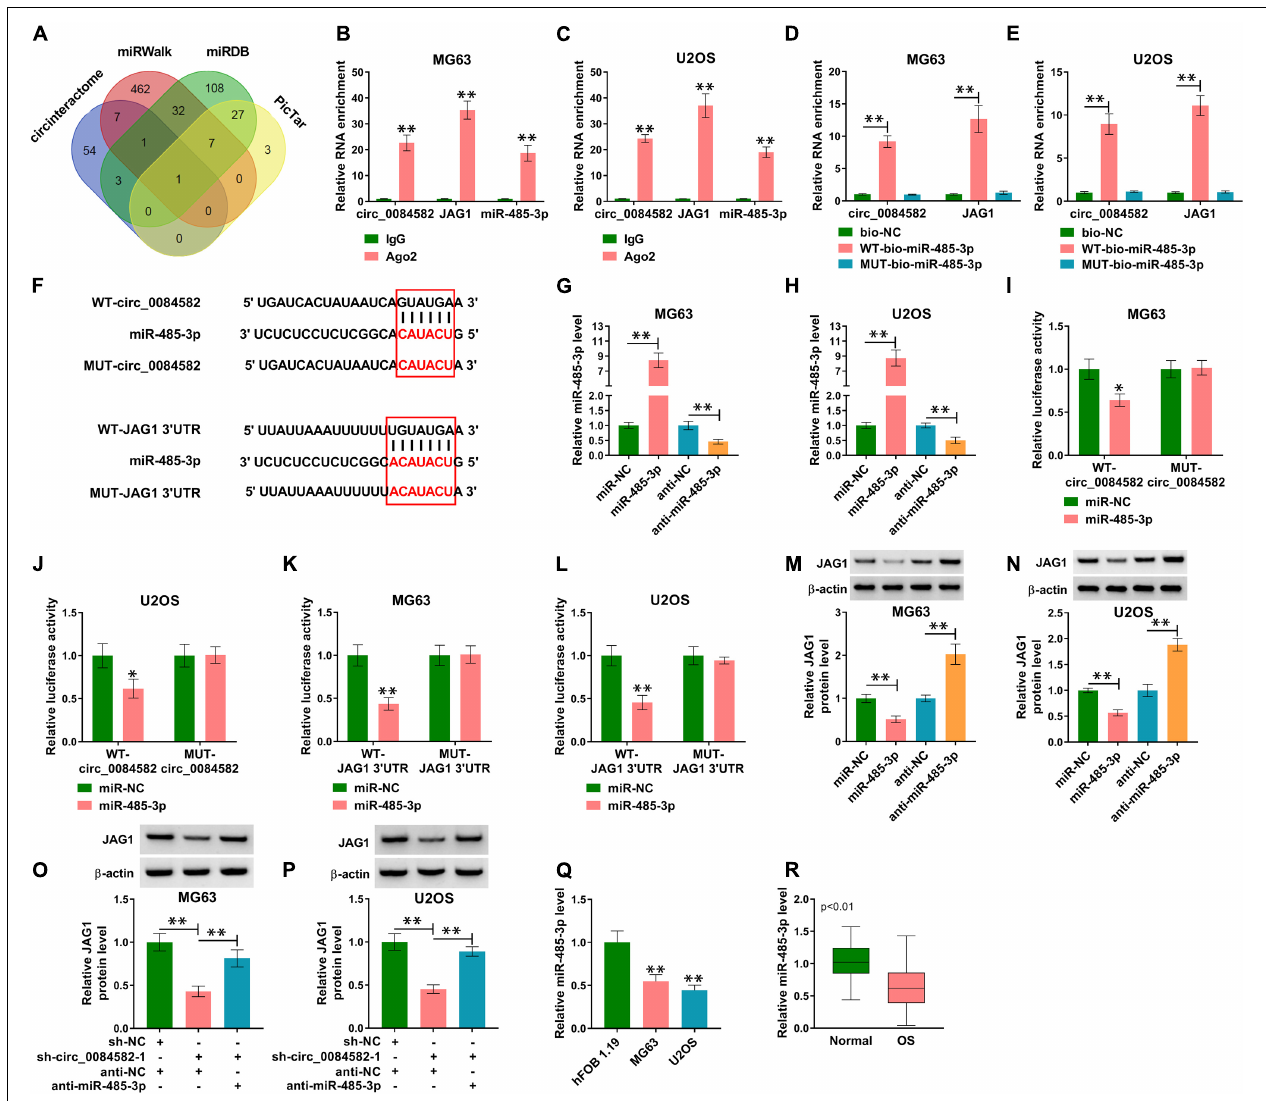
FIGURE 5 | Circ_0084582 regulated the JAG1 expression by sponging miR-485-3p. (A) The mutual miRNA in target prediction for circ_0084582 and JAG1 was selected by Venn diagram analysis. (B–E) The potential binding between miR-485-3p and circ_0084582 or JAG1 was analyzed by RIP (B,C) and pull-down assays (D,E) . (F) Circinteractome and miRDB, respectively, show the binding sites between miR-485-3p and circ_0084582 or JAG1. (G,H) The efficiencies of miR-485-3p mimic and inhibitor were assessed by qRT-PCR in MG63 and U2OS cells. (I–L) The dual-luciferase reporter assay was used to affirm the interaction between miR-485-3p and circ_0084582 (I,J) or JAG1 (K,L) . (M,N) The effects of miR-485-3p overexpression or downregulation on JAG1 expression were analyzed via Western blot. (O,P) JAG1 protein level was assayed using Western blot after MG63 and U2OS cells were transfected with sh-NC, sh-circ_0084582-1, sh-circ_0084582-1 + anti-NC, or sh-circ_0084582-1 + anti-miR-485-3p. (Q,R) The miR-485-3p expression quantification was conducted using qRT-PCR in OS cells (Q) and tissues (R) . All experiments were performed with three biological replications. ∗ P < 0.05, ∗∗ P <